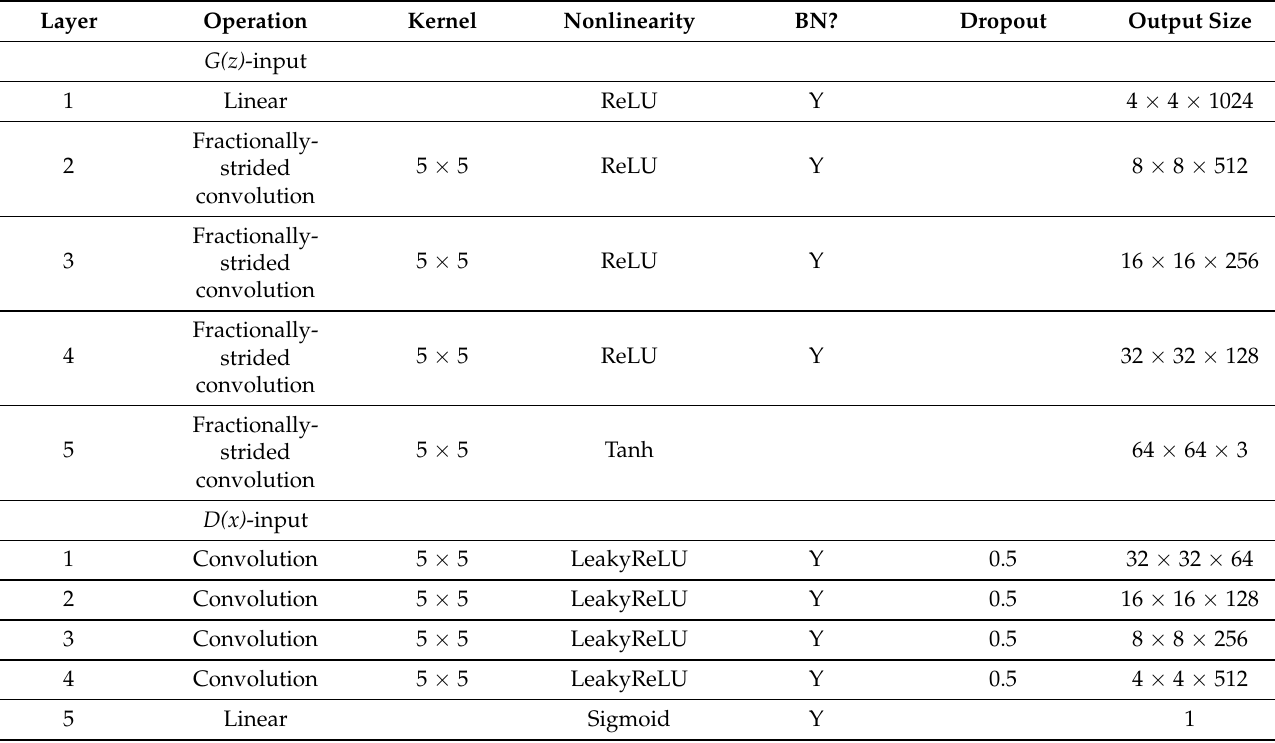
Table 2. The architecture of WLgenerateNet (stride =